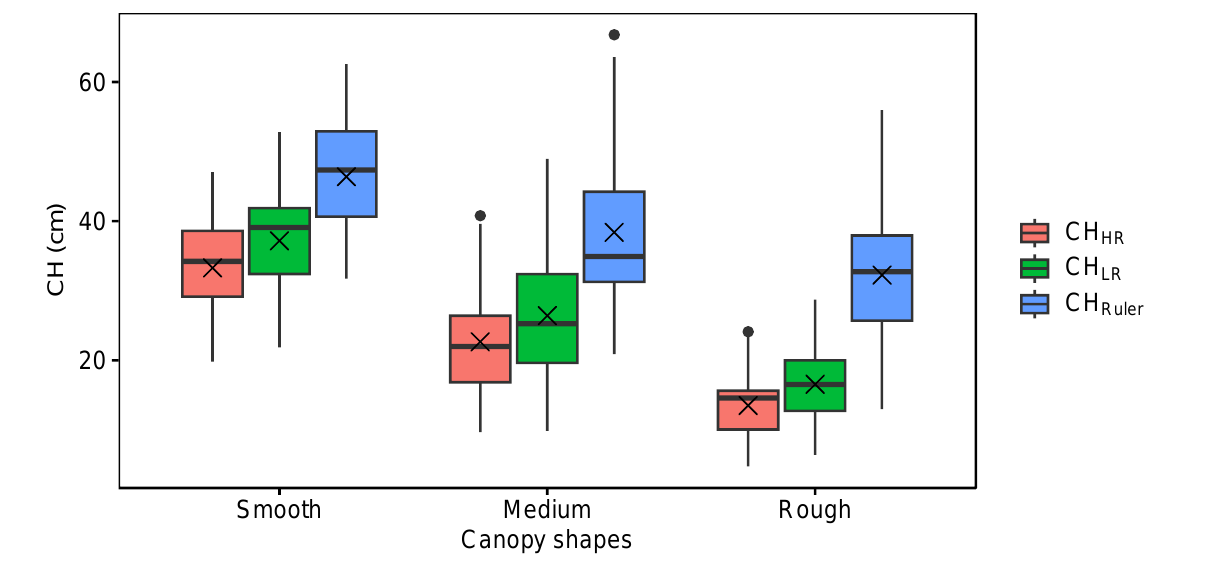
Figure 7. Comparison of mean canopy heights (CH) of cover crops from ruler-based method (CH Ruler) , low-resolution UAV mission (CH LR ), and high-resolution UAV mission (CH HR ) separated into rough, medium, and smooth canopy shapes. X indicates the mean of grouped values. Regression models were fitted to answer the initial question of whether the biomass of cover crops is predictable by CH determined with UAV-based RGB imaging (Figure 8). Dry matter shoot biomass of the investigated cover crops yielded between 0.34 and 4.3 Mg ha −1 . Logarithmic relationships between the measures were found, with an R 2 = 0.76 for the HR and LR RGB imaging and 0.75 for the ruler method. As expected, the intercept of the HR model was lower than the intercept of the LR model and even lower than the ruler model. However, slight differences were found, and the RMSE was nearly identical for the three models (Figure 8).